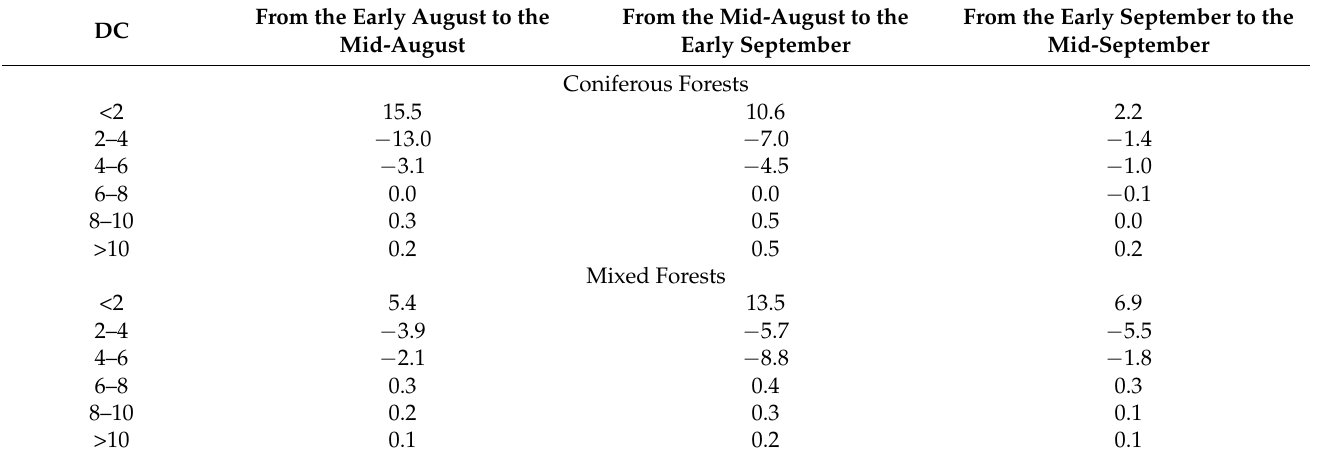
( a ) ( b ) ( c ) Figure 8. Distribution of broadleaved forests unaffected by drought (DC < 2) in the middle of August 2019 ( a ), at the beginning of September 2019 ( b ), and in the middle of September 2019 ( c ), scale 1:1,000,000. 3.1.8. LCCs Vegetation Response to Drought Stress in 2019 and 2020 The differences in the spatial distribution of the individual drought categories in the studied ecosystems in 2019 and 2020 directly reflect the variations in ecological conditions, caused by the manifestation of the climatic elements (Figures 9 and 10). The whole of 2019 was warmer and drier than 2020 [69]. The analysis of climatic data, acquired in four me- teorological stations located in the study area, shows that the mean average air tempera- ture in August 2019 was higher by 0.9 °C (22 °C) than that in 2020 (20.1 °C) [69]. The av- erage precipitation sum in August 2019 was 21.55 mm, ranging between 22.4 mm in the lower territories and 9.1 mm in the high mountains, distributed over an average of 4.25 days in the month and concentrated in early August (1–5 August 2019) [69]. In August